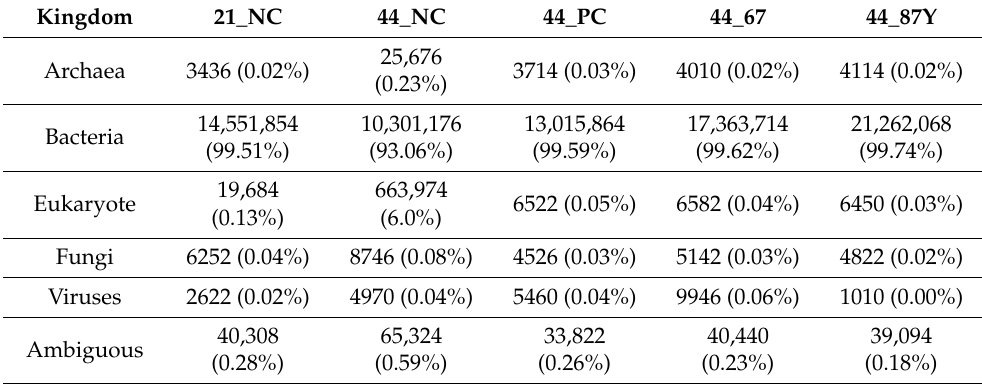
Table 7. Number of reads assigned to different kingdoms. Ambiguous—reads which cannot be assigned to one specific kingdom; Eukaryote —parasitic and non-parasitic Protozoa